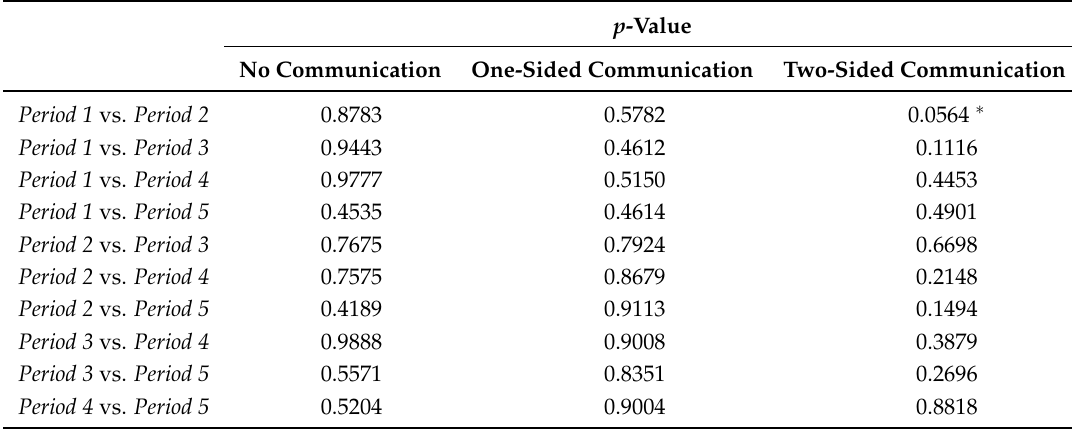
Table A1. Mann Whitney U tests: Comparisons of individual average offers across